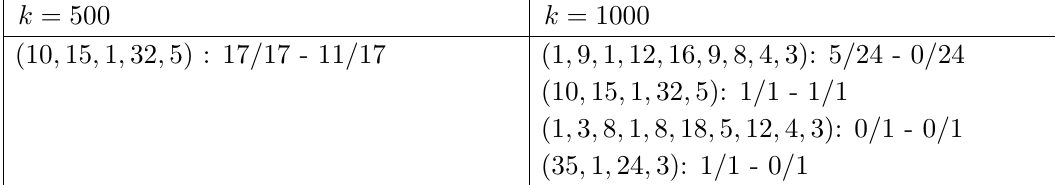
Table 12 . Kaq ness for L 26 on su (8) . Format is “ ( d i ) : Fraction of solutions with the pattern ( d i ) that were (partially- kaq ) - ( kaq )”. The last two patterns in k = 1000 were found upon further search and are not in